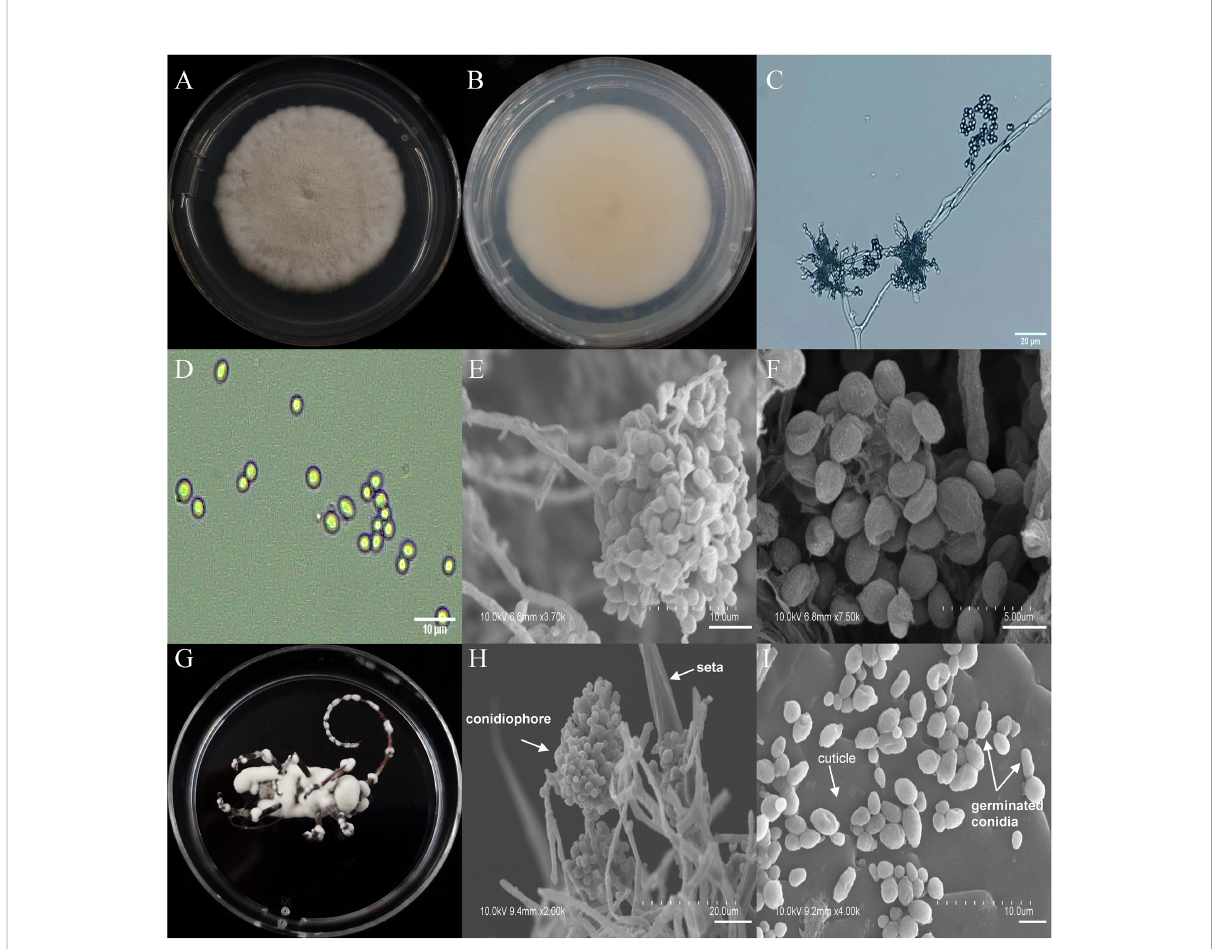
FIGURE 4 Morphology of B . bassiana and M . alternatus cadaver infected by B . bassiana under optical microscope and SEM. (A) Colonial morphology cultured on PDA. (B) Reverse of colony on PDA. (C) Hyphae and conidiophores (OM). (D) Conidia (OM). (E) Conidiophores (SEM). (F) Conidia (SEM). (G) M . alternatus cadaver surrounded by mycelia. (H) Conidiophores grown from M . alternatus cuticle (SEM). (I) Conidia on M . alternatus cuticle surface